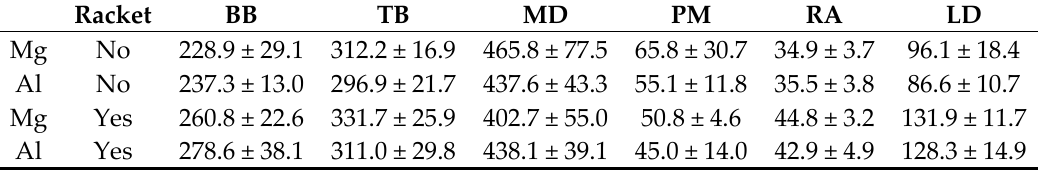
Table 7. Mean amplitude and standard deviation of mean amplitude for One Stroke (back stroke). Racket